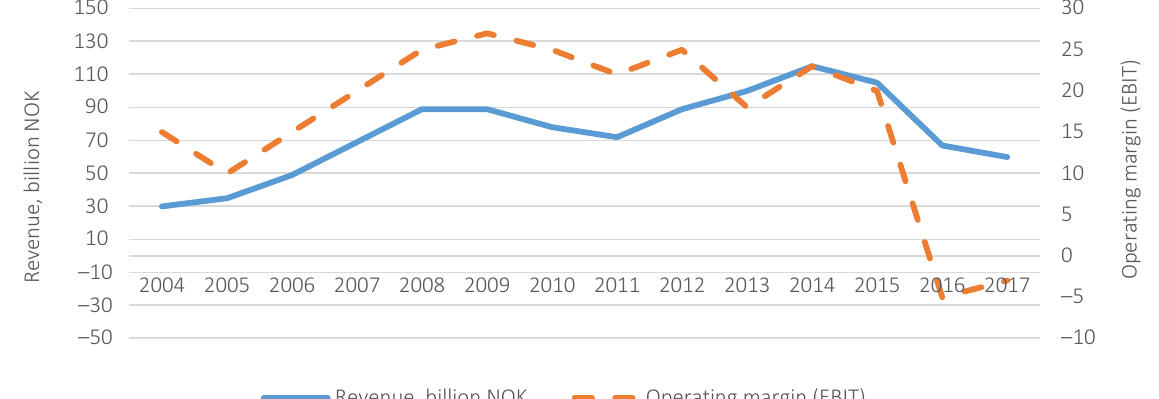
Figure 9. Turnover and operating margin among equipment suppliers